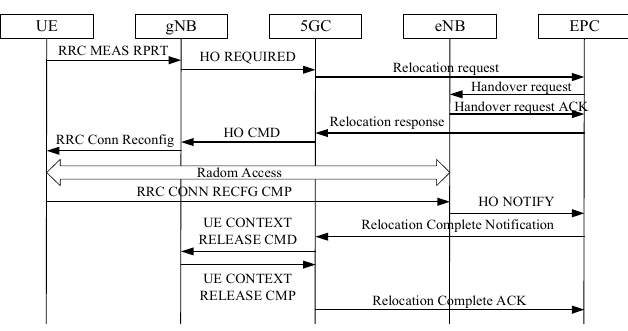
Figure 9. Handover process from VoNR to VoLTE.